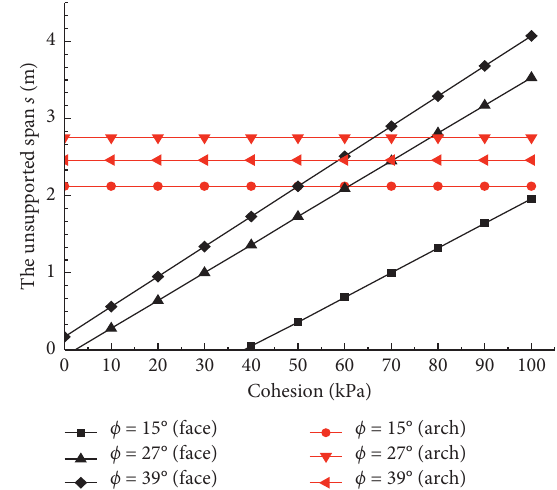
Figure 11: Curves of correlation between the unsupported span and